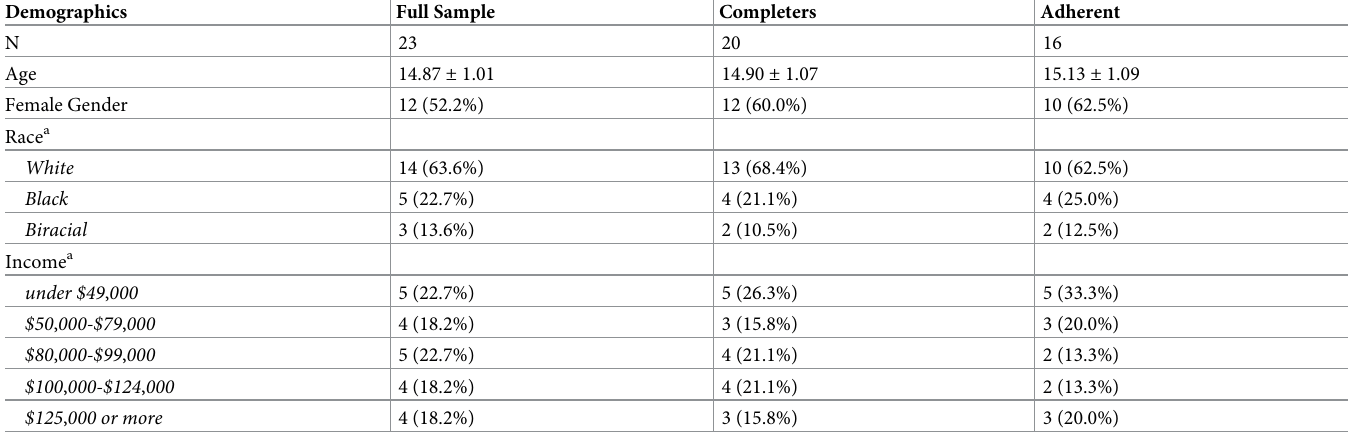
Table 2. Demographic information for participants attending at least the initial office visit (“full sample”), those attending all three office visits (“completers”), and those adherent to the study protocol